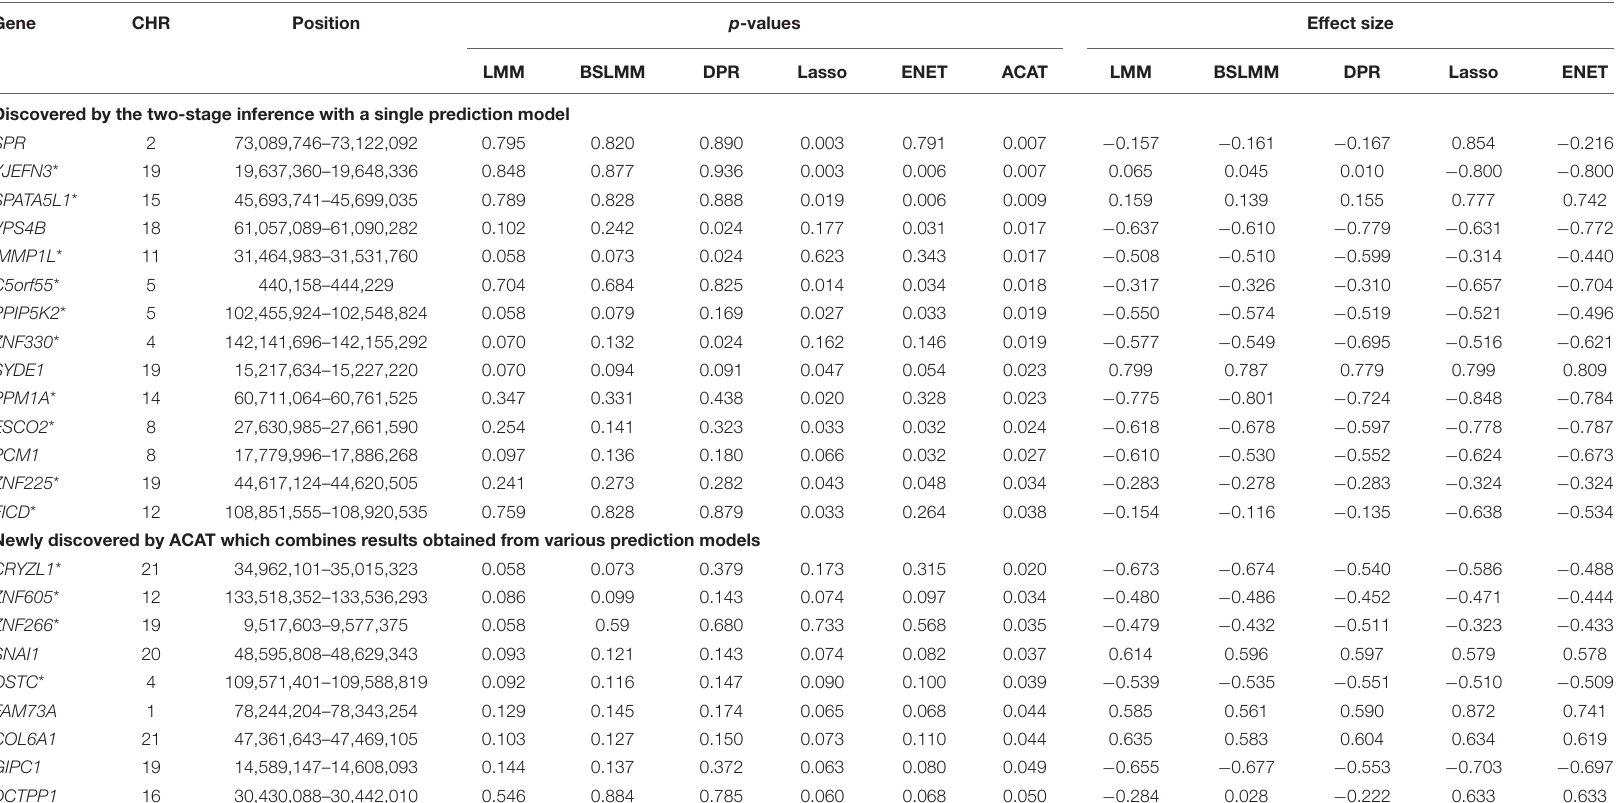
TABLE 2 | A total of 23 associated genes identified via the proposed two-stage causal inference